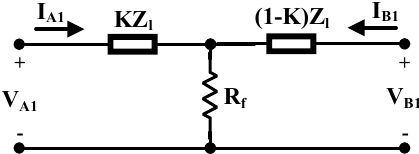
Figure 3. SPS equivalent circuit for 3P fault.